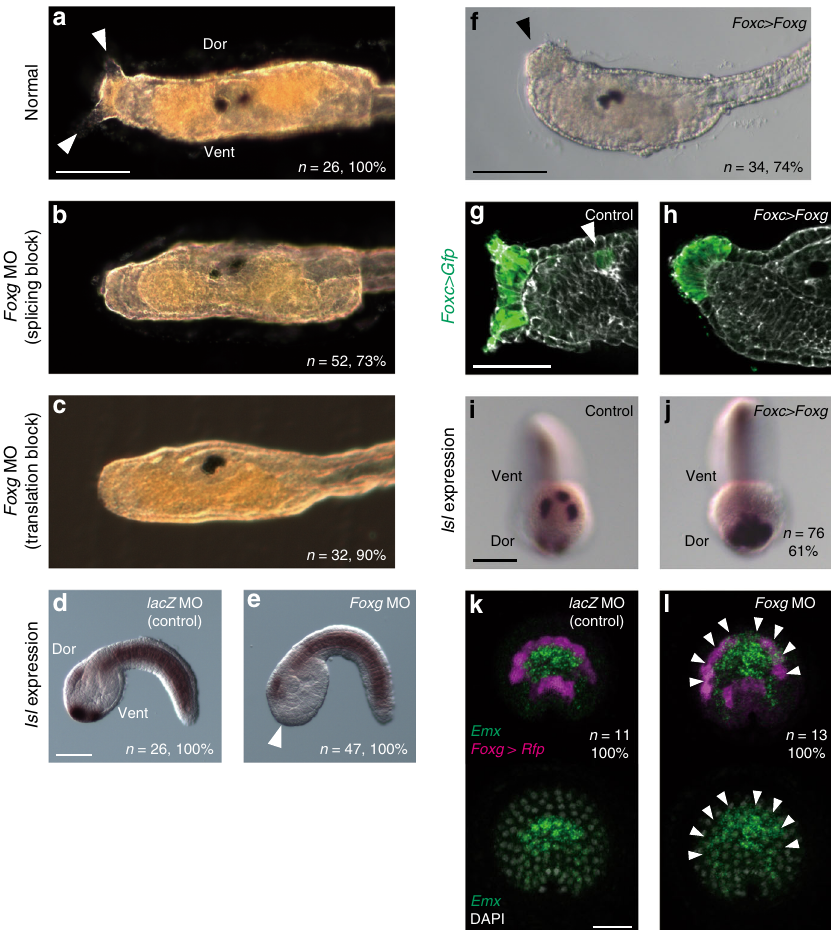
Fig. 3 Foxg is essential for palp formation. a – c Morphology of the larval trunk developed from a control unperturbed eggs, b eggs injected with a MO designed to block splicing of Foxg RNA, and c eggs injected with a MO designed to block translation of Foxg mRNA. While two of three palp protrusions are visible in normal embryos shown in ( a ) (arrowheads), no palp protrusions are visible in the morphants shown in ( b ) and ( c ). d , e Isl expression in embryos injected with d the control lacZ mRNA and e the Foxg MO. The palp-forming region lost Isl expression in the Foxg morphant shown in ( e ) (arrowhead). Lateral views are shown. f A larva in which Foxg was over/misexpressed using the upstream region of Foxc developed a single large palp (arrowhead). g , h The ANB cells were marked with GFP by introducing the Foxc > Foxg construct and counterstained with phalloidin (gray). The anterior trunk regions of g a control larva and h a larva in which Foxg was over/misexpressed are shown. g In normal embryos, ANB cells contribute to the palp region and the oral siphon primordium (arrowhead). h In embryos with Foxg over/misexpression, all Gfp-positive cells were found in the single large palp. i , j Isl expression in ( i ) a control embryo and ( j ) an embryo with Foxg over/misexpression. Isl is expressed in the entire palp-forming region in ( j ). k , l Fluorescence in situ hybridization for Emx and Rfp . Embryos were injected with k the lacZ MO or l the Foxg MO. Foxg > Rfp was coinjected to mark the most anterior and posterior rows of the ANB and detected by in situ hybridization. In ( l ), ectopic expression of Emx was detected in the anterior row. The number of embryos examined and the proportion of embryos that each panel represents are shown within the panels. The brightness and contrast of fl uorescence images were adjusted linearly. Scale bars represent 50 μ